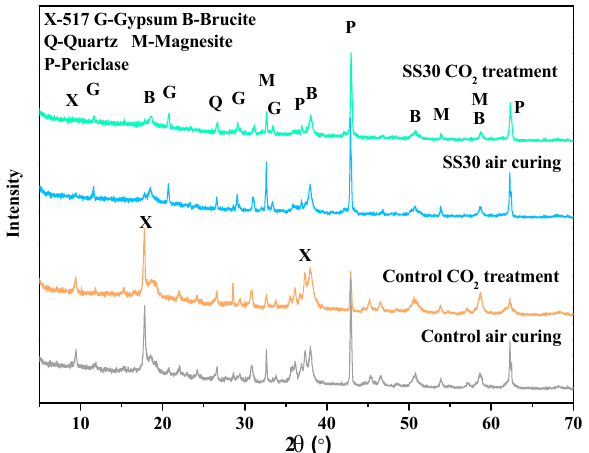
Figure 7. Powder XRD patterns of the control and SS30 with and without CO 2 treatment after water immersion for 28 days.